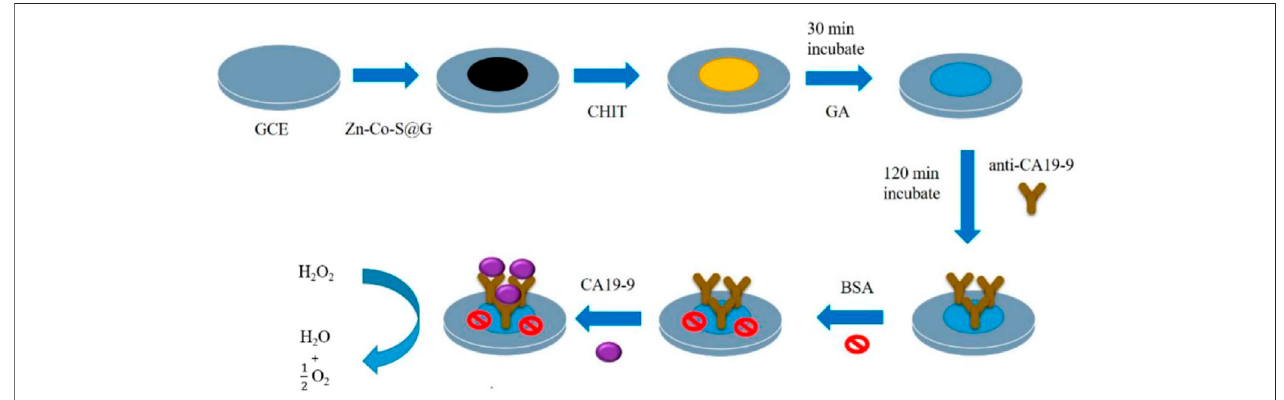
FIGURE 1 | Scheme of fabrication of the Zn-Co-S/graphene electrochemical immunosensor for CA199